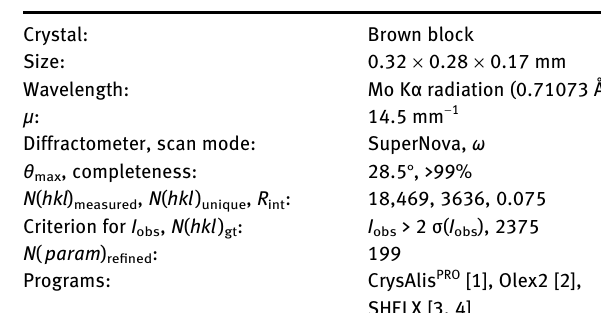
Figure 1: Molecular structure of the title compound with displacement ellipsoids draw at the 50% probability